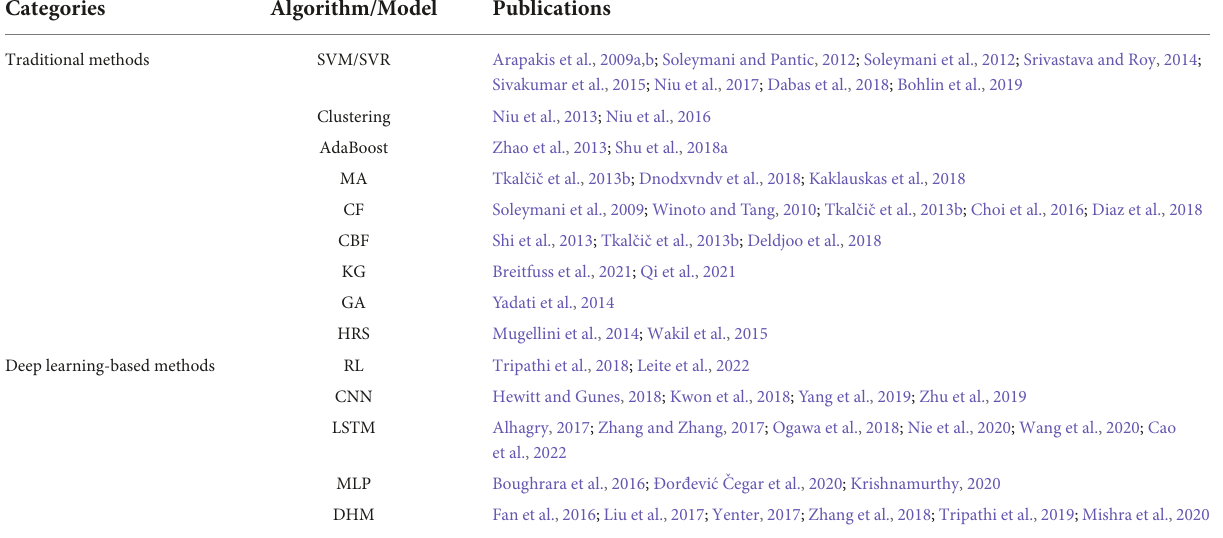
TABLE 3 Publications based on different